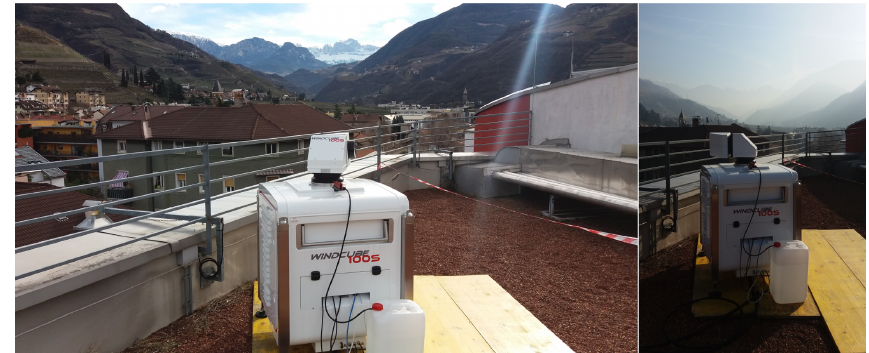
Figure 4. The WINDCUBE 100S Doppler wind lidar from Leosphere (France) installed on a roof at 18ma . g . l . In the background is the outlet of the Isarco